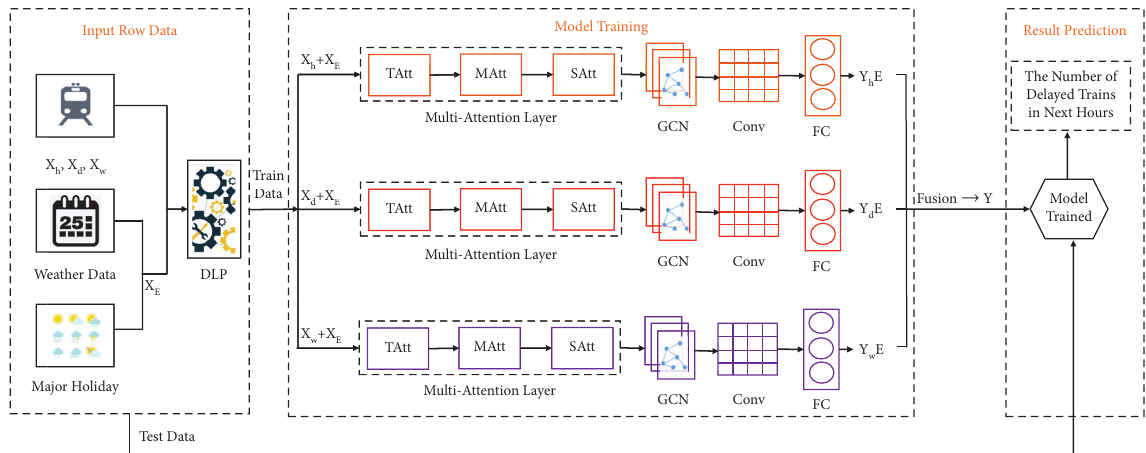
Figure 1: Structural diagram of MATGCN train delay model. TAtt: temporal attention mechanism, MAtt: multifeature attention mechanism, SAtt: spatial attention mechanism, GCN: graph convolution neural network, Conv: convolution layer, FC: fully connected